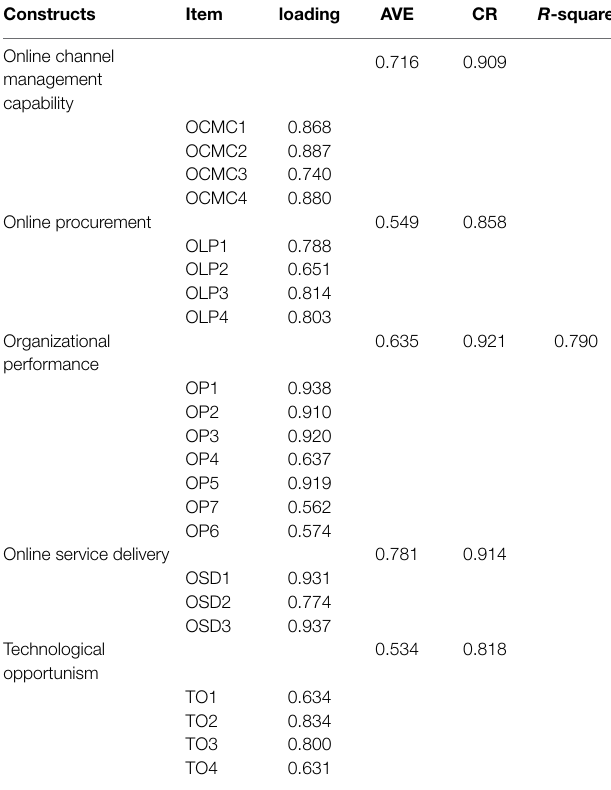
TABLE 1 | Measurement. Constructs Item loading AVE CR R -square Online channel